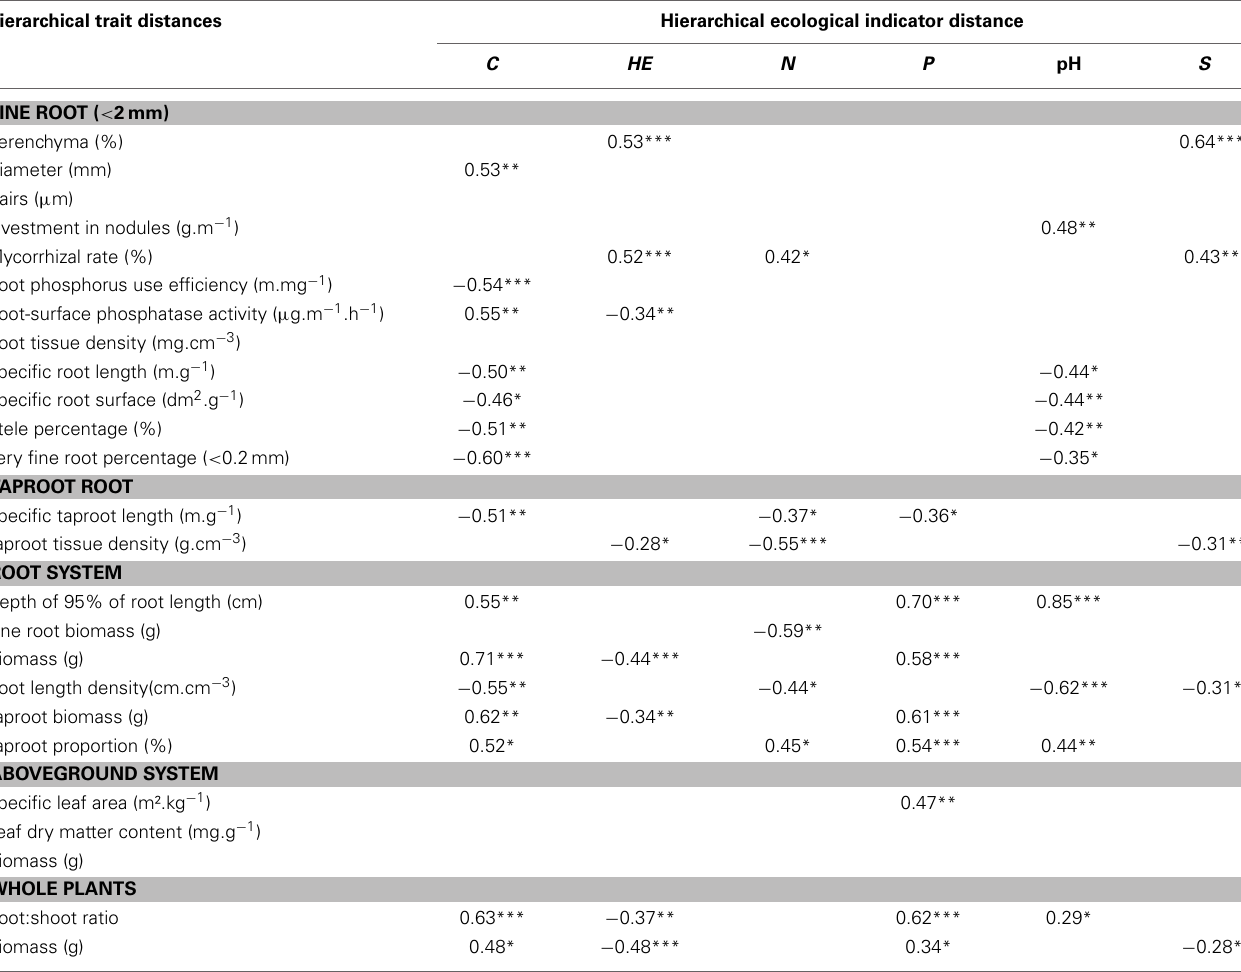
Hierarchical trait distances Hierarchical ecological indicator